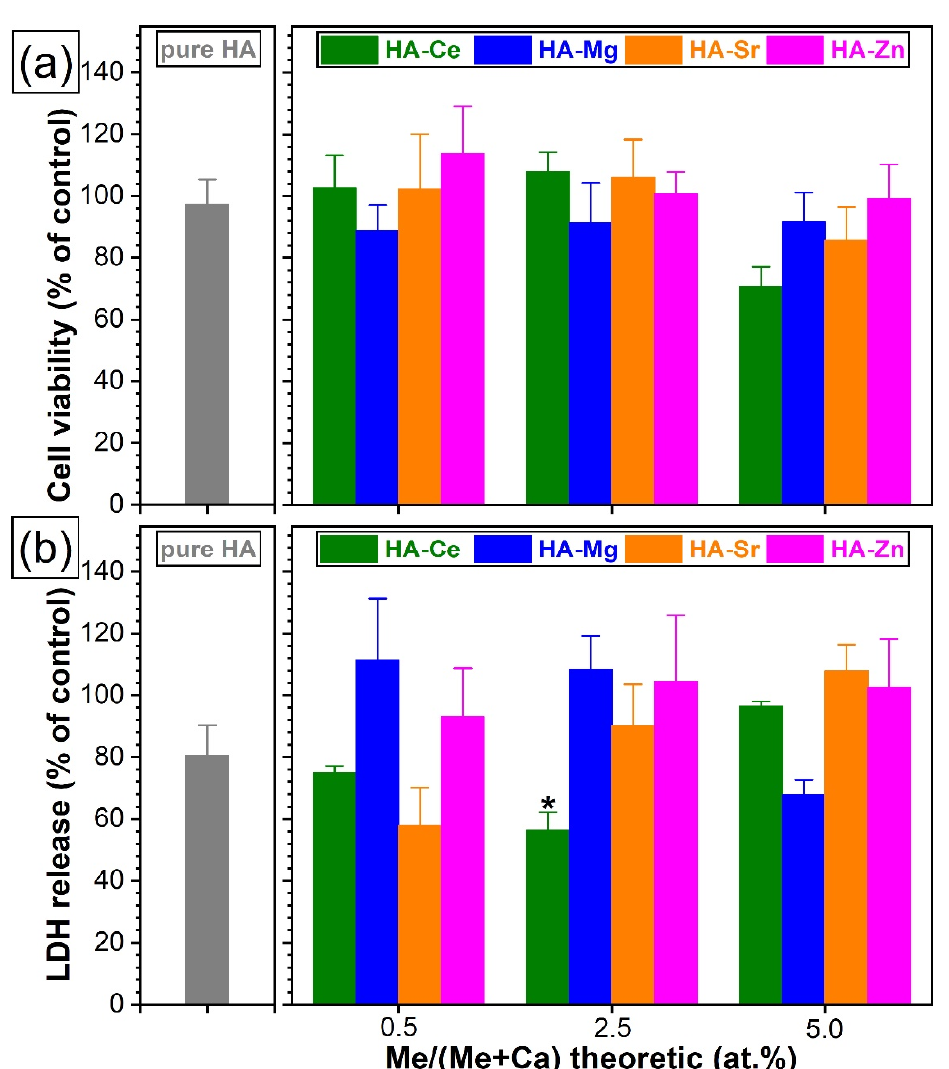
Figure 11. The NIH/3T3 (ATCC ® CRL − 1658™) mouse fibroblast ( a ) cell viability (evaluated by a 3-(4,5-dimethyl thiazol-2-yl) 5-(3-carboxymethoxyphenyl)-2-(4-sulfophenyl)-2H-tetrazolium assay—MTS assay) and ( b ) cytotoxicity (inferred by a lactate dehydrogenase release test—LDH) evaluated after 48 h in the case of the pure and substituted HA NPs. The ( a ) MTS and ( b ) LDH results are presented as means ± standard deviations (n = 3) and were obtained as a percentage of the control. * p < 0.05, statistically significant differences with respect to pure HA as determined by using a one-way ANOVA multiple analysis followed by a Dunnett’s post hoc test.